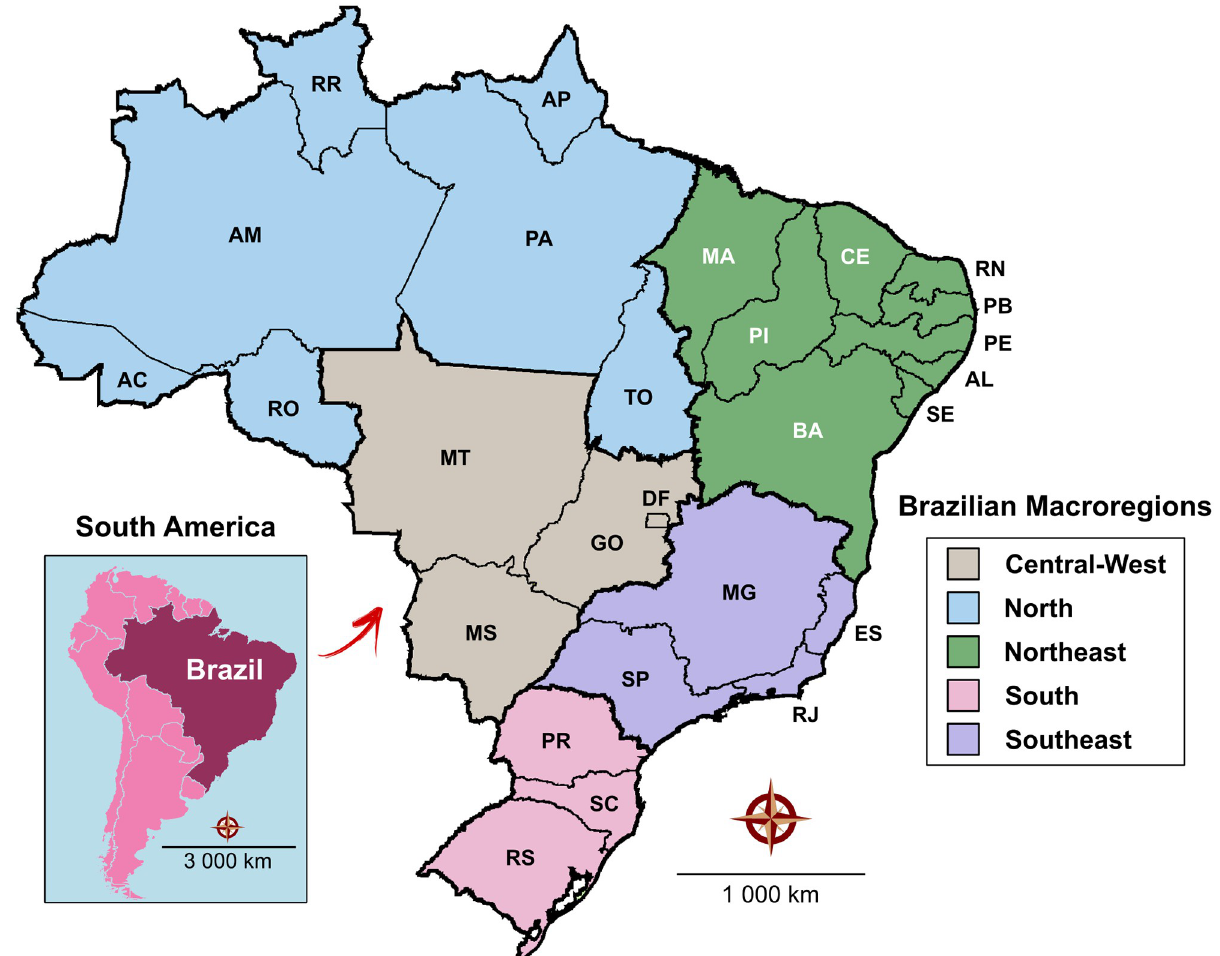
Fig 1. Geographic division of Brazil into five macroregions, 26 states and a Federal District (DF). Macroregions and corresponding state abbreviations: North (AC: Acre, AM: Amazonas, AP: Amapa´, RO: Rondoˆnia and RR: Roraima); Northeast (AL: Alagoas, BA: Bahia, CE: Ceara´, MA: Maranh ã o, PB: Paraı´ba, PE: Pernambuco, PI: Piauı´, RN: Rio Grande do Norte and SE: Sergipe); Central-West (DF: Distrito Federal, GO: Goia´s, MS: Mato Grosso do Sul and MT: Mato Grosso); Southeast (ES: Espı´rito Santo, MG: Minas Gerais, RJ: Rio de Janeiro, and SP: S ã o Paulo); South (PR: Parana´, RS: Rio Grande do Sul and SC: Santa Catarina). Digital maps in the public domain (publicly available) were obtained from IBGE cartographic database in shapefile format (.shp), which was subsequently reformatted and analyzed using QGIS version 3.10. Authors specify that this figure is licensed under CC BY